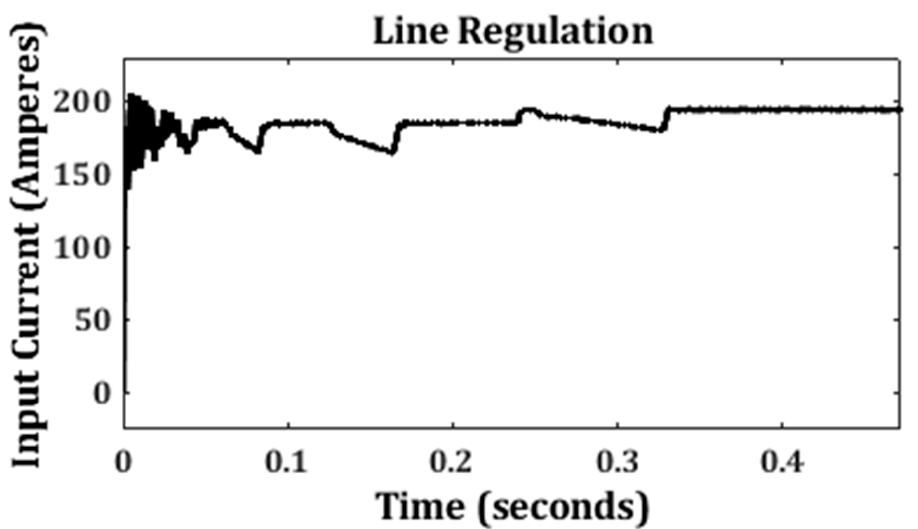
Figure 43. Input current in amperes during the line regulation.